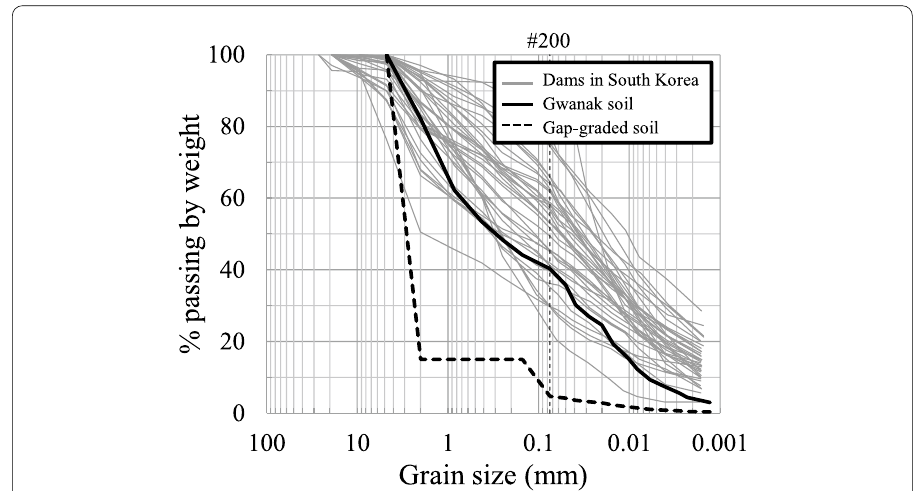
Fig. 1 Grain size distributions of gap‑graded silty sand and Gwanak